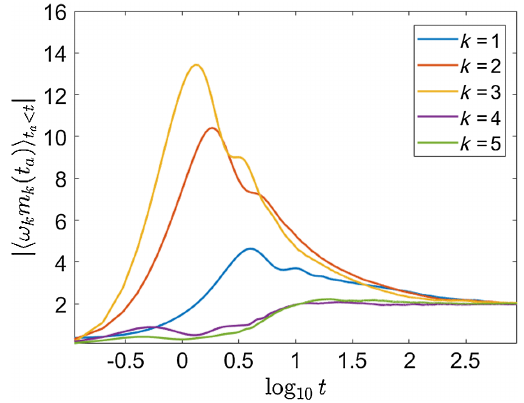
FIG. 6. Time evolution of the first five modes of the averaged a Þ t t ¼ 0 to t ¼ 1000 , with ϵ ¼ 10 . quantity jh ω k m ð a Þi t a <t j from k ð